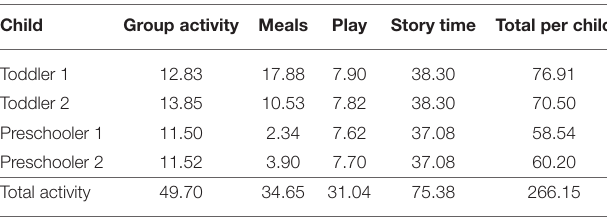
TABLE 2 | Total video duration in minutes for group activities, mealtime, play time, and story time for the four focus children.